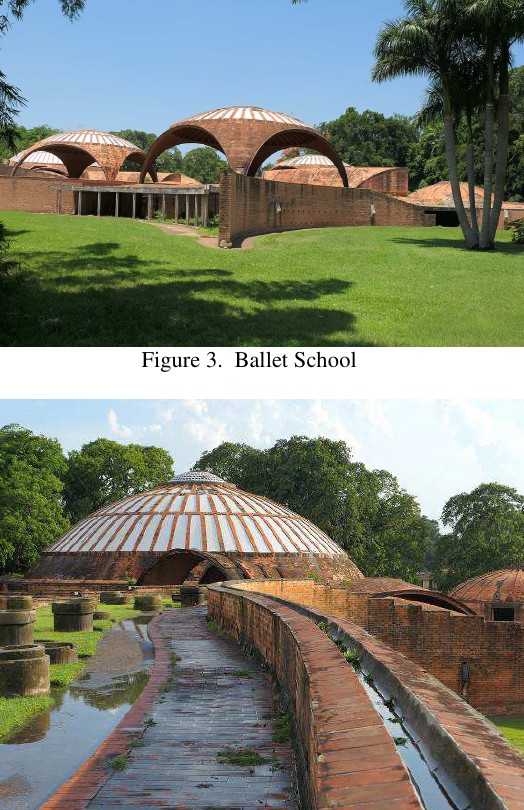
Figure 4. Ballet School